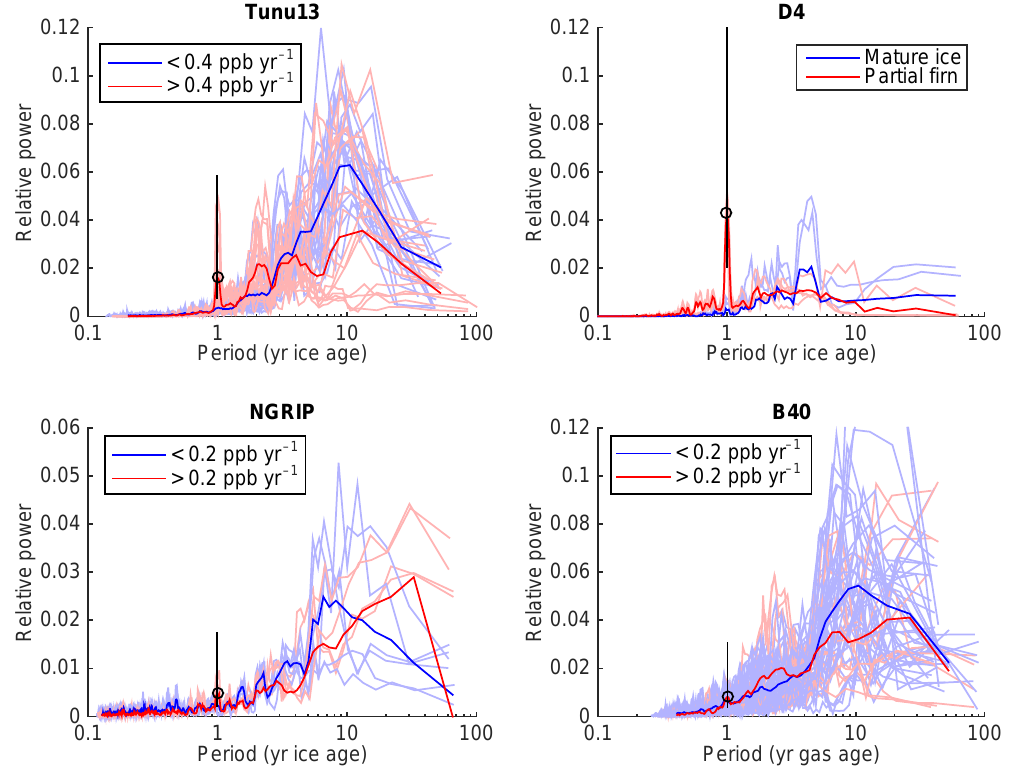
Figure 7. Multi-taper method (MTM) spectra of high-frequency, non-atmospheric residual CH 4 variability of four ice cores. MTM was performed in the ice age domain using 2 tapers and 3 ◦ of freedom. Each spectrum represents a 40years window of data. For Tunu13, NGRIP and B40 each spectrum is colour-coded according to the CH 4 growth rate of that data window. For D4, spectra are colour-coded according to whether or not the time window encompasses data from the lock-in zone (<82m depth). All D4 spectra represent time windows of CH 4 growth rate >0.4ppbyr − 1 . The bold lines represent averaged spectra for the low/high growth rate or mature ice/partial firn categories. The mean relative power at 1-year period is displayed (black open circles) with vertical lines representing the 90% confidence intervals for the averaged spectra (bold, red lines only) based on a chi-squared distribution. Spectral peaks are significant for Tunu13 and D4 because the confidence interval exceeds the background spectral